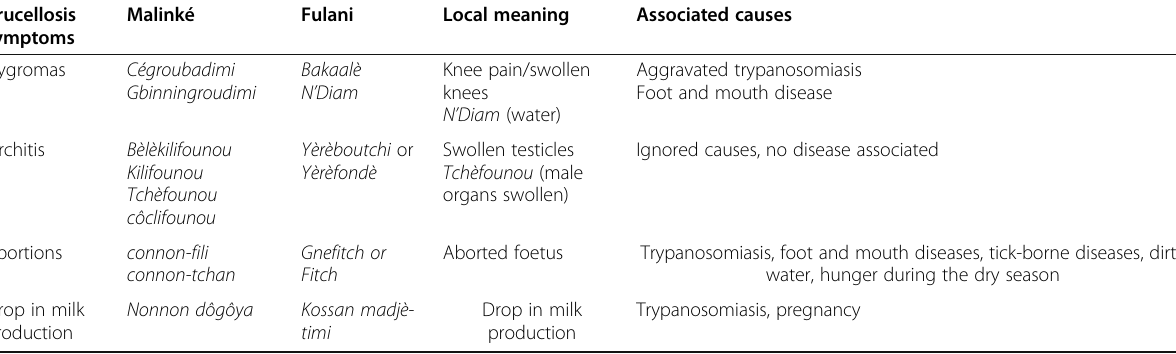
Table 2 Associated Popular Nosological Entities (PNE) of major brucellosis symptoms in animals and their associated causes Brucellosis Malinké Fulani Local meaning symptoms